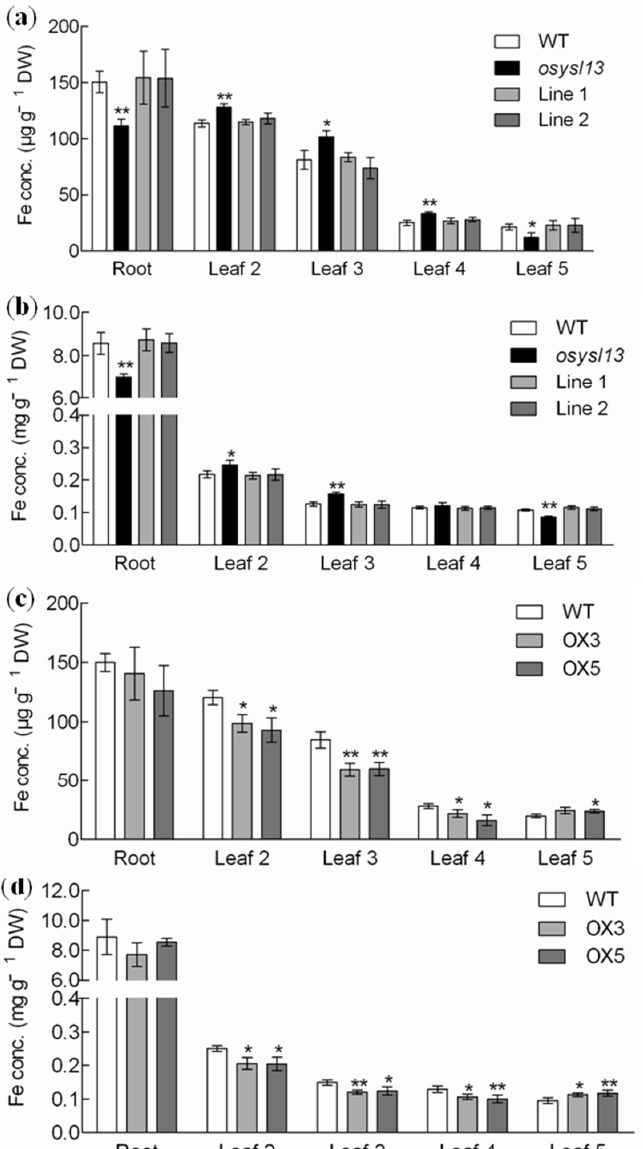
that OsYSL13 is involved in Fe distribution to the youngest leaf. Besides, the Fe concentrations in the roots of osysl13 mutant were reduced under both Fe deficiency and sufficiency, compared with its wild type and two independent complementation lines (Figure 6a,b). However, there was no significant difference in Fe concentrations in the roots between the OsYSL13 overexpression lines and wild type (Figure 6c,d).